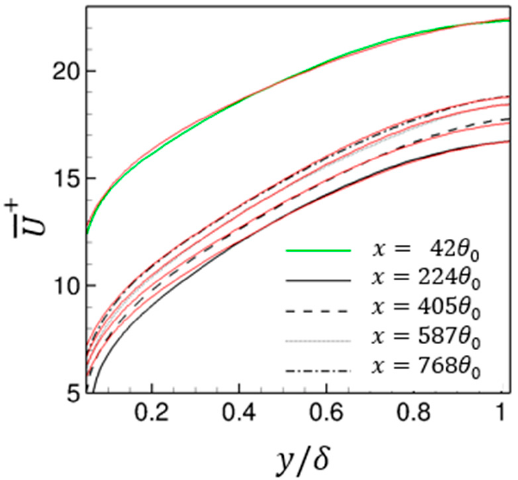
Figure 9. Wall normal 𝑦/𝛿 variation of inner-scaled mean velocity profiles at discrete 𝑥 stations for case 𝑅 . The red solid lines represent the estimated profiles for Coles’ law of the wake: 𝑈 + = 1 𝑙𝑛 𝑦 (cid:2878) + 𝐴 + (cid:2870)(cid:3069) 𝑓( (cid:3052) ). Each profile in red corresponds to a different wake strength parameter 𝛱 , which is extracted from Figure 8.